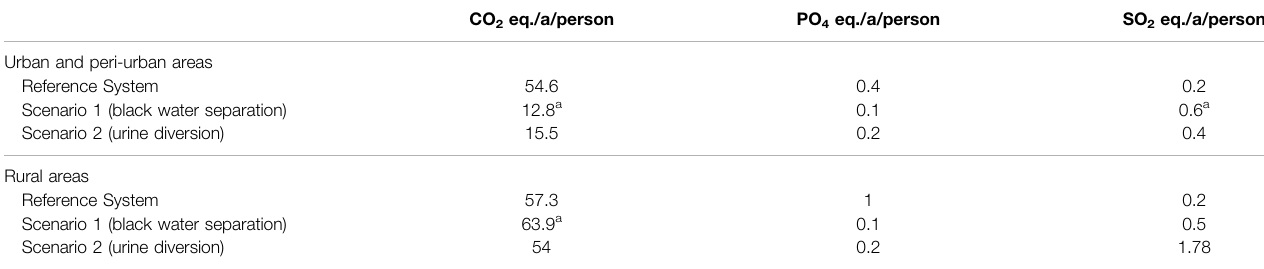
TABLE4| Emissionfactorsforclimatechange(CO 2 eq.),eutrophication(PO 4 eq.)andacidi fi cation(SO 2 eq.)basedonLehtorantaetal.(2022)forperi-urbanareasandMalila et al. (2019) for rural